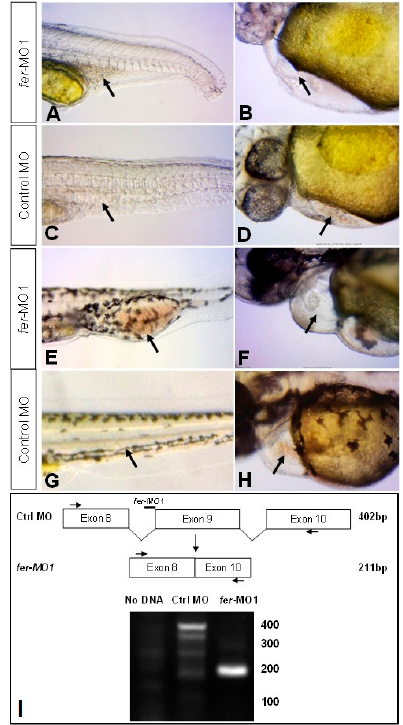
Figure 2. Fer knockdown results in apparent vasculature blockage and accumulation of developing hematopoietic cells. At 30 somites, fer -MO1 embryos exhibit convergence extension defects along the anterior–posterior axis with red blood cells that are pooled in the posterior ICM region ( A ) with none present in the pumping heart ( B ), when compared to wildtypes (( C , D ) respectively). By 48 hpf, the lack of circulating red blood cells and empty heart chambers is emphasized in the Fer knockdown embryos ( E , F ) compared to wildtype embryos ( G , H ). Agarose gel electrophoresis of fer -reverse